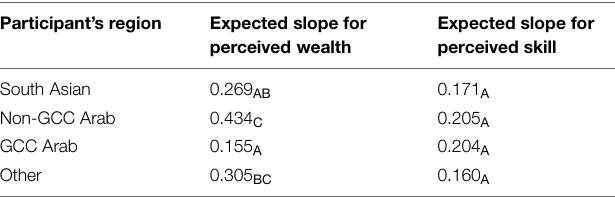
TABLE 7 | Slopes and homogenous subsets for perceived wealth and perceived skill by participant’s region. Participant’s region